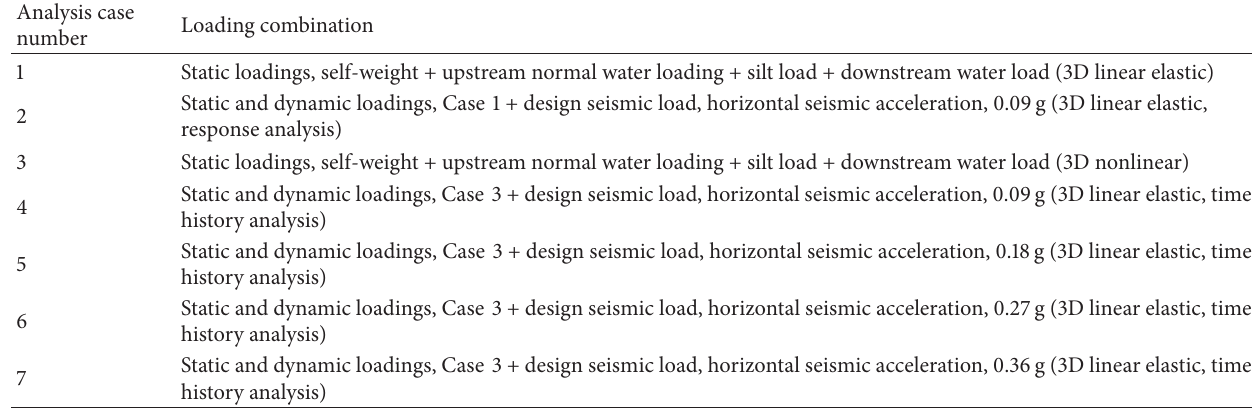
Table 3: Summary of the analysis cases studied in the 3D finite element